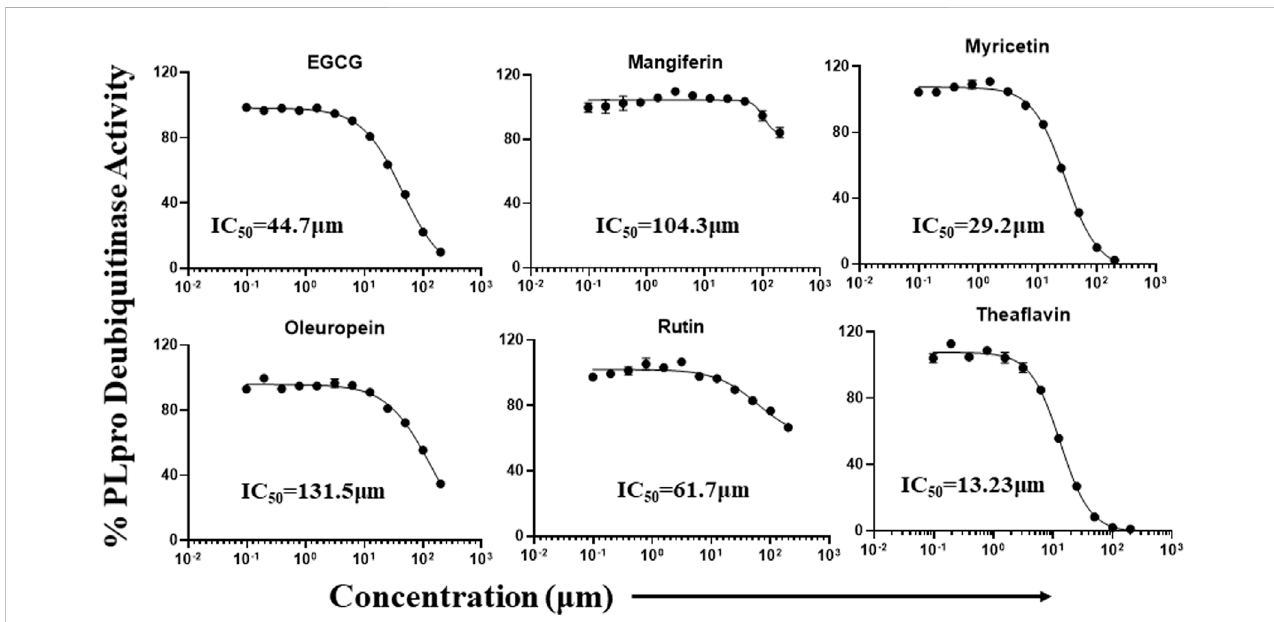
Dose-dependent inhibition of SARS-CoV-2 PLpro DUB activity by EGCG, mangiferin, myricetin, oleuropein, rutin, and thea fl avin: The phytochemicals that exhibited at least 50% inhibition of DUB activity of PLpro enzyme were selected and screened for their dose-dependent inhibitory activity as described under Martials and Methods. The fl uorescence intensity was used to calculate the percent enzymatic activity considering DMSO treated control as 100% activity. Blank values were subtracted before calculating the percent activity. Representatives of four individual experiments (n = 4) with triplicate values wereanalyzedusingGraphPadPrism8andpresentedgraphically.IC50valueswerecalculatedusingnon-linearregression(curve fi t)withfourvariabledosevs . inhibition by GraphPad Prism8.